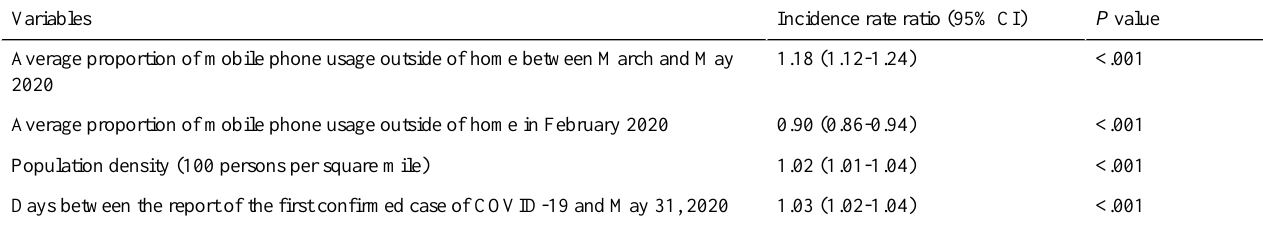
Table 1. Mixed-effects negative binomial model examining the impact of social distancing on COVID-19 mortality (deaths per 100,000 people) in US counties between the period of the report of the first case of COVID-19 and May 31, 2020.